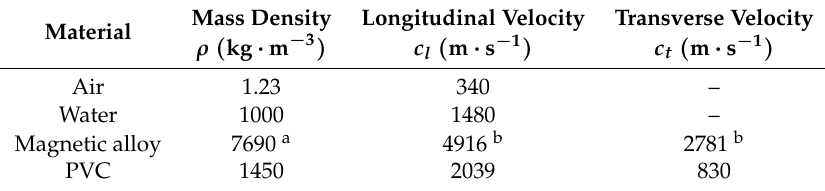
Table 2. Materials’ elastic parameters used in the